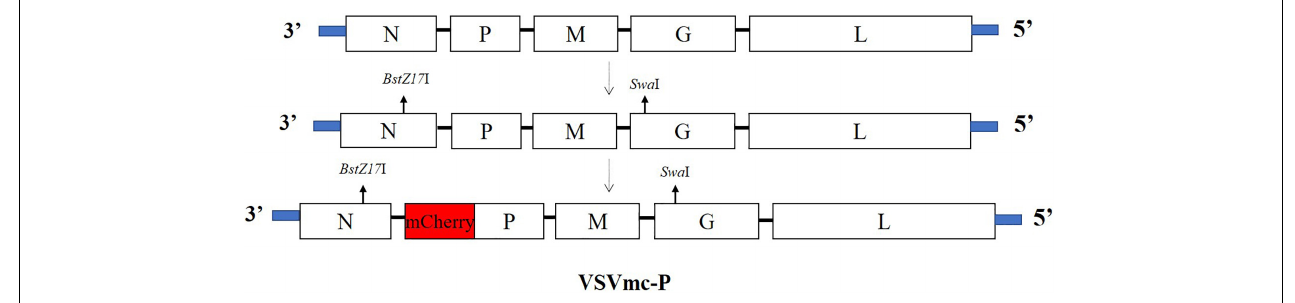
FIGURE 6 | Schematic diagram of recombinant VSV expressing the mCherry gene (rVSVmc-p). The VSV genome is depicted in schematic representations (top), with insertion locations indicated by arrows (second) and VSV vectors including a transcription cassette encoding mCherry (bottom),